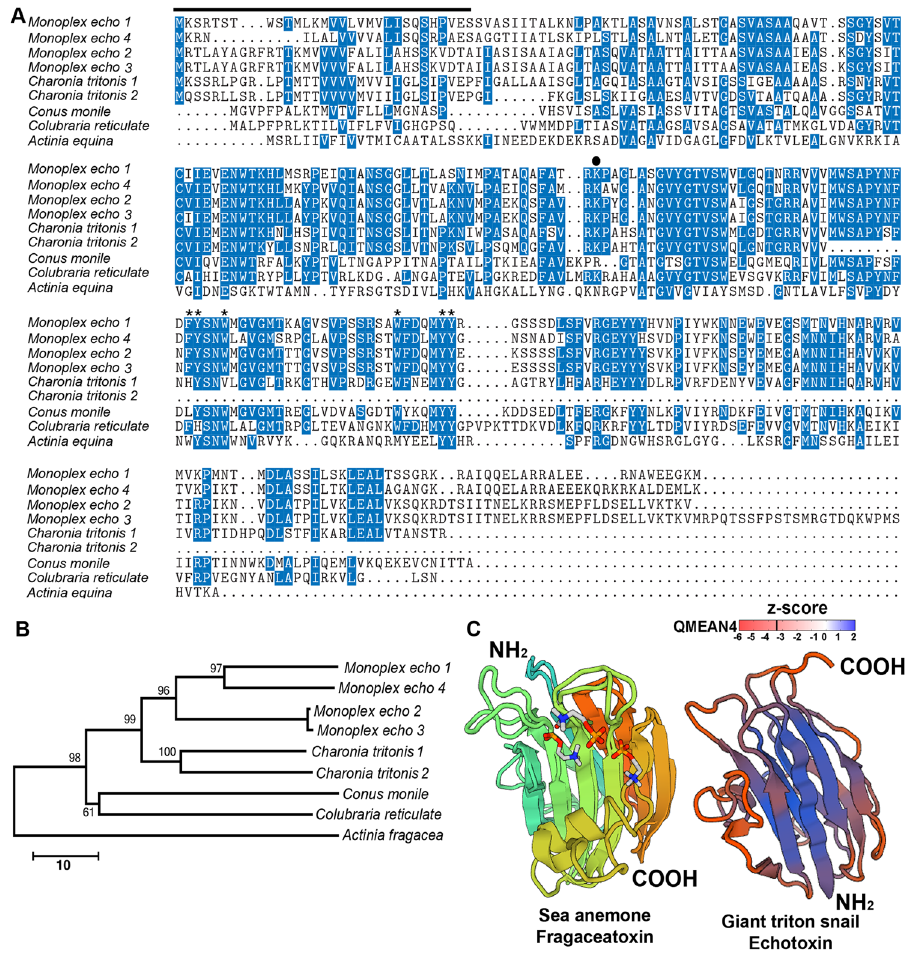
Figure 5. Molecular characterization of Charonia tritonis echotoxin proteins. ( A ) Multiple sequence alignment of C. tritonis echotoxin and with echotoxins from other species. Genbank accession numbers for all proteins are provided in Supplementary Data S8. Shading represents high amino acid conservation and the line shows region of signal peptide based on M. echo . The Lys (K) residue and residues involved in the aromatic patch are indicated by a closed circle and asterisks, respectively. ( B ) Phylogenetic tree of echotoxin proteins using neighbor-joining estimation. Scale bar represents amino acid substitutions. ( C ) 3D structure of fragaceatoxin from sea anemone (SWISS-MODEL id: 4tsn.3.A; identity 22.68% and sequence similarity 0.32) and the predicted C. tritonis echotoxin model, shown using ribbon representation in DeepView. Analysis of Z-scores of the template protein (fragaceatoxin) and echotoxin from C. tritonis shows the geometrical features responsible for an observed negative value. Large negative values correspond to red regions in the color gradient, and light red and deep blue region represents maximum match with protein used for modelling and the experimental protein. The structure reveals up to one ligand (phosphocholine) bound to a single chain of fragaceatoxin, a single binding site is also present in the echotoxin of C. tritonis